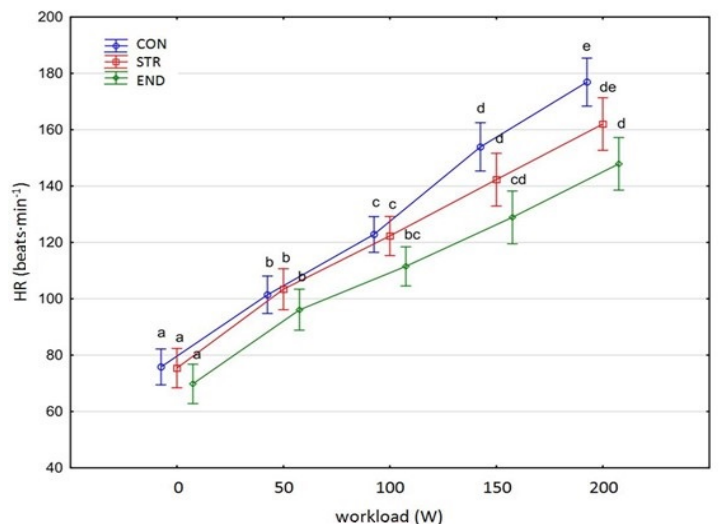
Figure 1. Heart rate (HR) at rest and its response during the progressive exercise test; point and whiskers—mean ± 95% CI; the signs—a, b, c, d, e indicate homogeneous groups ( post-hoc Tukey’s HSD test: p > 0.05).